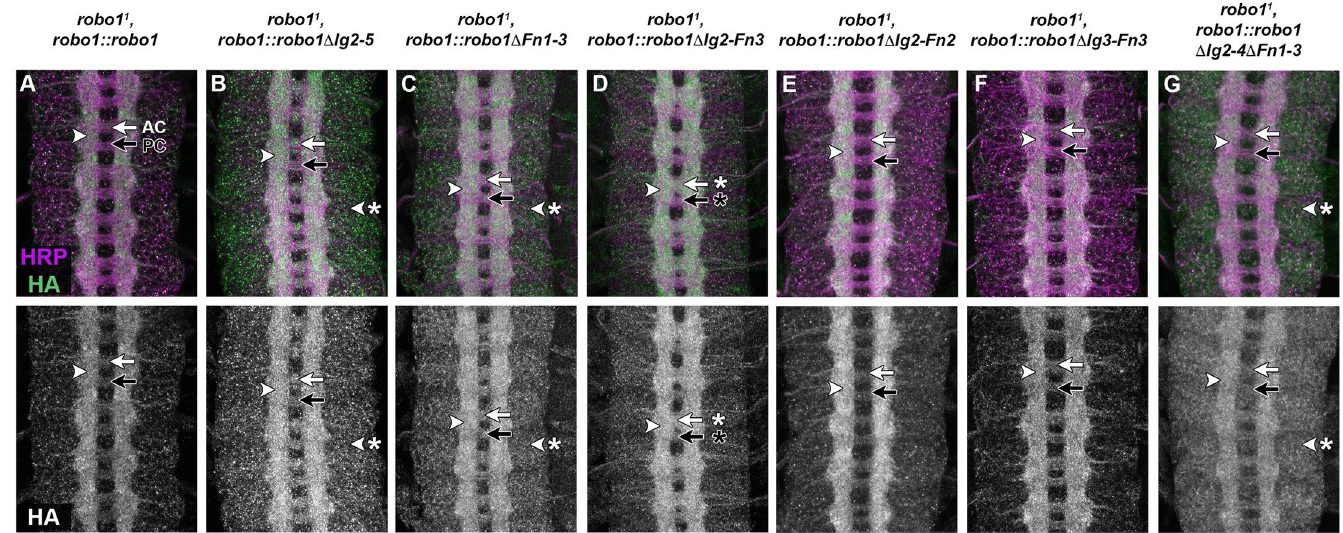
Fig 3. Expression of Robo1 variants in robo1 mutant embryos. Stage 16 embryos stained with anti-HRP (magenta) and anti-HA (green) antibodies. Bottom images show HA channel alone from the same embryos. (A–G) Expression of full-length Robo1 via the robo1 rescue transgene in a robo1 null mutant (A) restores the wild-type structure of the axon scaffold. Each of the combinatorial Ig ( Δ Ig2-5) and Fn ( Δ Fn1-3) deletion variants restore axon scaffold morphology to a similar extent as full- length Robo1 (B-C). However, when the two variant deletions are combined (Robo1 Δ Ig2-Fn3) the transgene is not able to completely restore the scaffold (D, arrows with asterisk). Adding back one domain restores wild-type axon scaffold morphology (Robo1 Δ Ig2-Fn2 E, Robo1 Δ Ig3-Fn3 F, Robo1 Δ Ig2-4 Δ Fn1-3 G). In the absence of endogenous robo1 , all of the variants are localized to the longitudinal pathways as in wild-type embryos (arrowheads). Robo1 Δ Ig2-5, Robo1 Δ Fn1-3, and Robo1 Δ Ig2- 4 Δ Fn1-3 display elevated expression levels in neuronal cell bodies (B-C, G arrowhead with asterisk) compared to the other Robo1 variants.